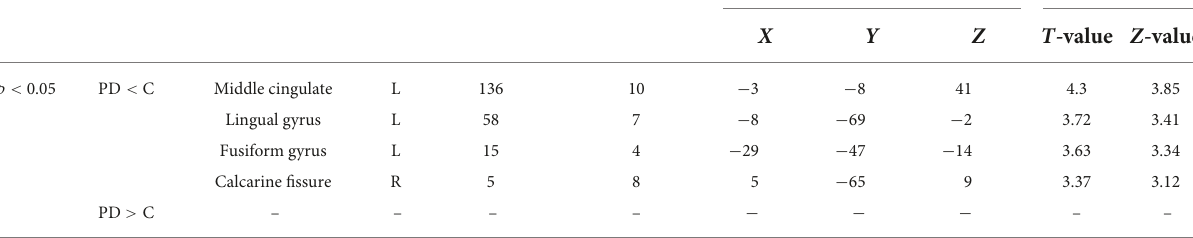
TABLE 2 Gray matter alterations detected by